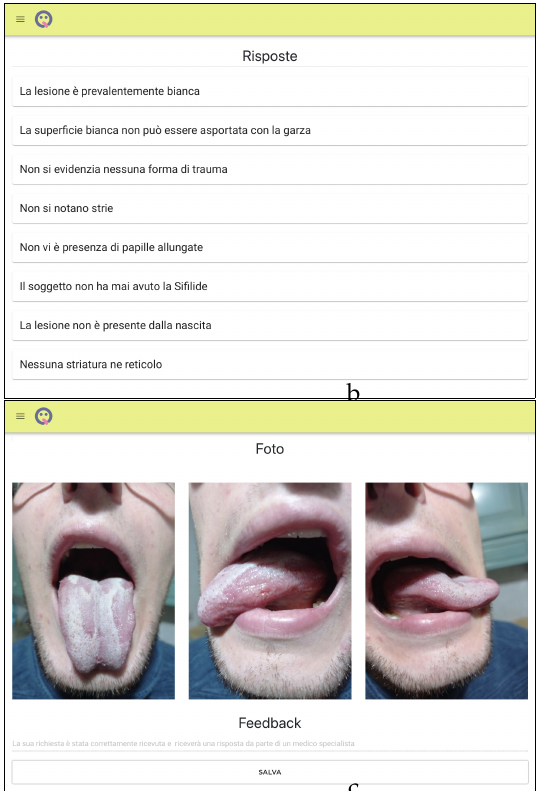
Figure 4. The web interface allows to create and modify the questionnaire, also through graphic representation ( a ). It is possible to delete or view details for an individual request on a dedicated page containing patient contact information, the selections made ( b ), and the attached photos ( c ). Sensitive data has been censored. LinguApp features Italian phrases that can be translated quite easily (please see Additional